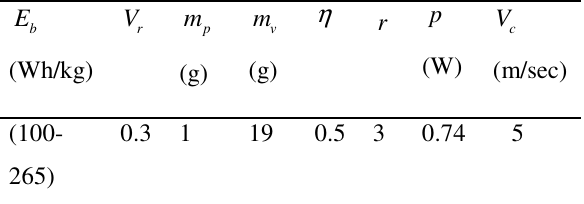
Figure 3: Flight time in Throttle and Hover condition vs Battery Capacity